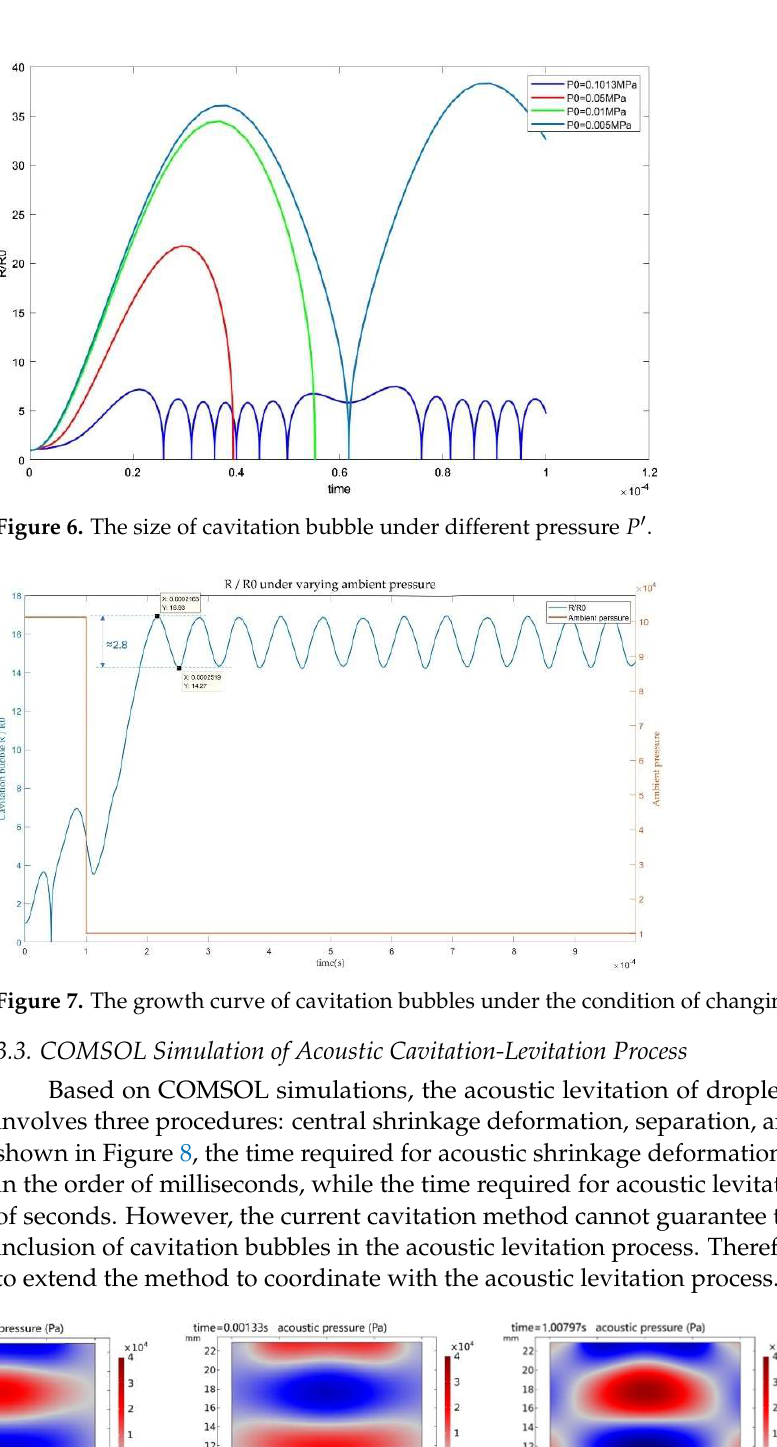
Figure 7. The growth curve of cavitation bubbles under the condition of changing ambient pressure.